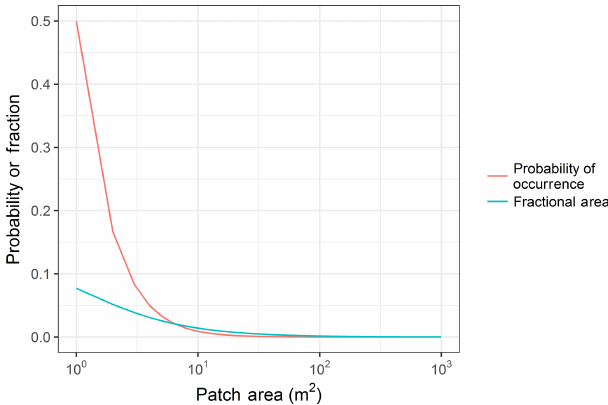
Figure 4. Probability of patch size occurrence and its transforma- to 1000m 2